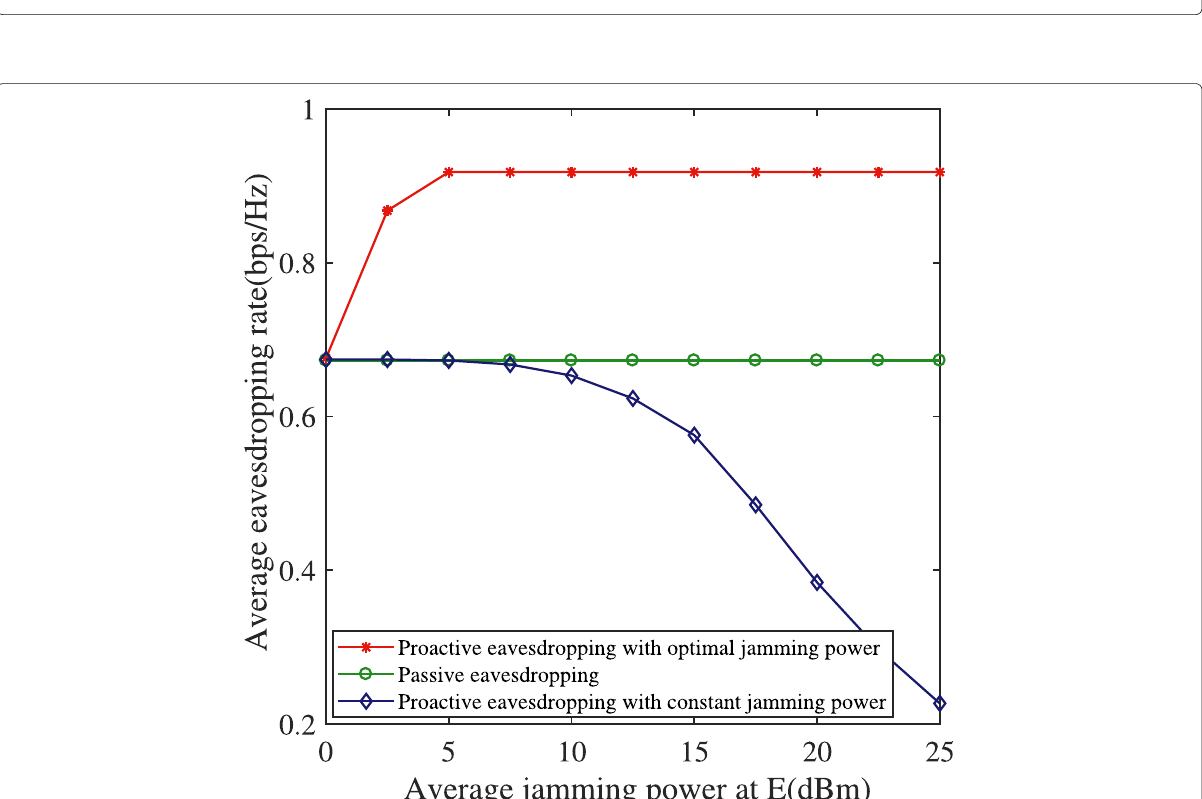
Fig. 3 Eavesdropping rate versus average jamming power ¯ Q for DF